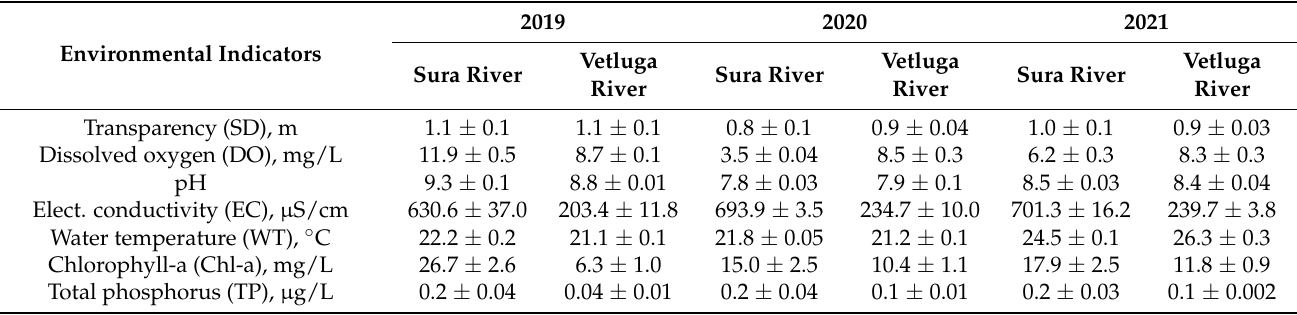
Table 1. Environmental indicators (mean ± SD) measured in the mouth areas of the Sura and Vetluga rivers